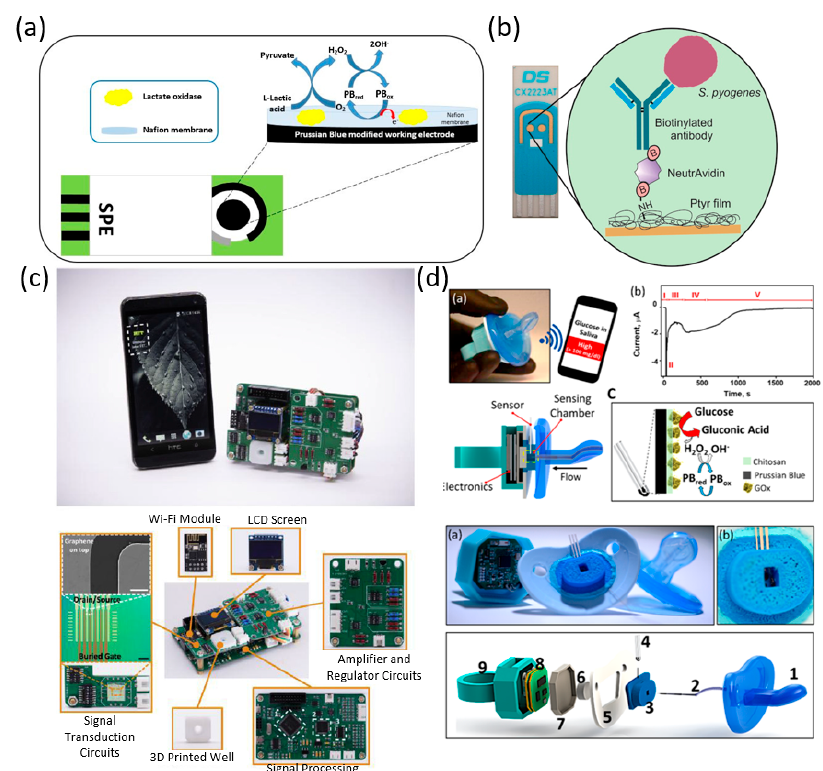
Figure 2. Portable biosensors for salivary diagnostics. ( a ) Schematic representation of SPE-PB-LOx Biosensor [14]. ( b ) Schematic of immunosensor against S. pyogenes [17]. ( c ) Images of aptameric GFET nanosensing system for cytokines detection [19]. ( d ) Glucose Pacifier sensing concept [25].